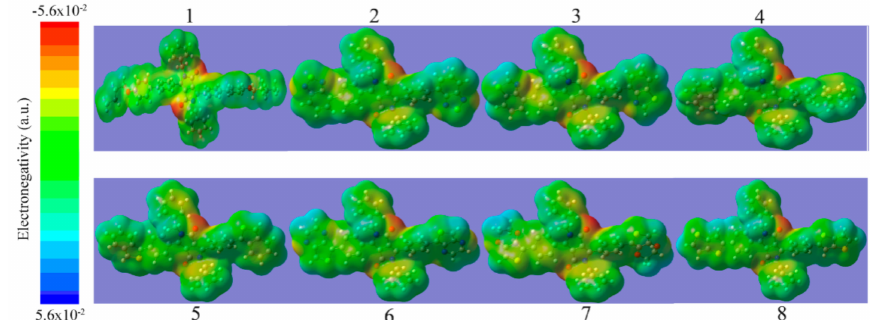
Figure 5. Electrostatic surface potentials for designed molecules. Regions of higher and lower electron density are shown in red and blue, respectively (values in atomic units).